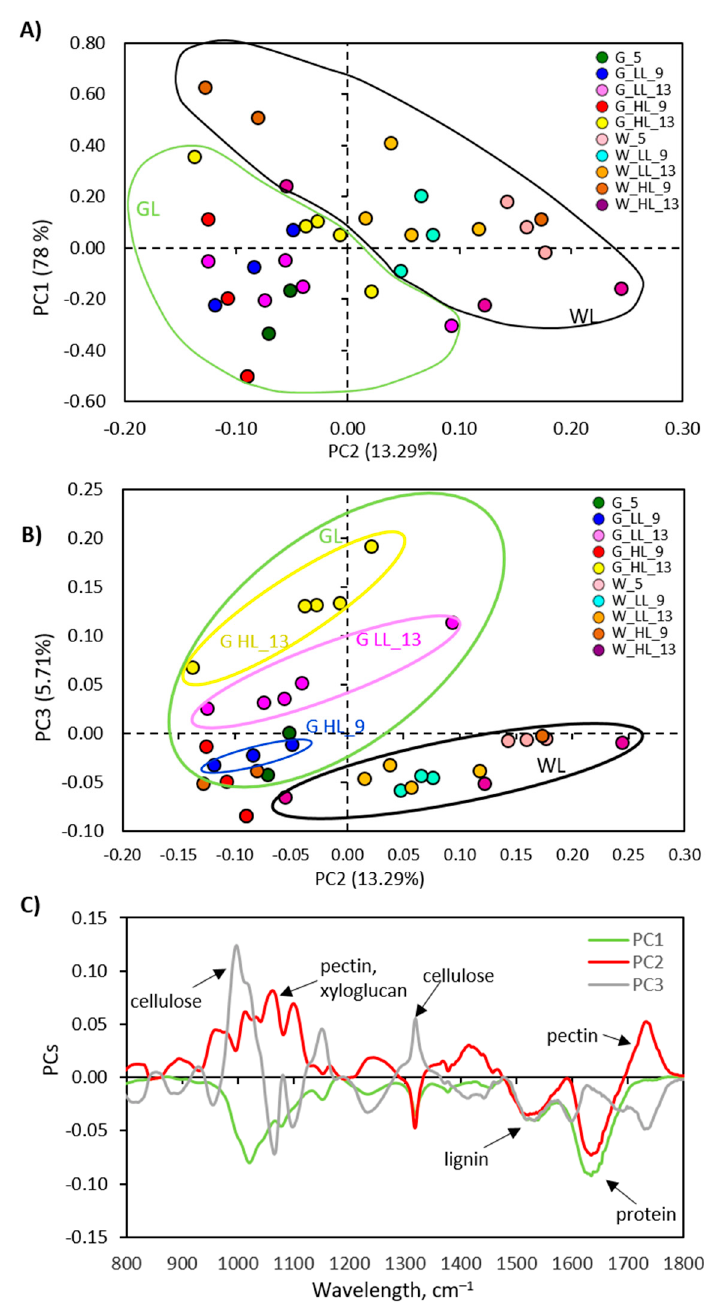
Figure 10. Graphical representation of the ( A , B ) scores and ( C ) loadings PC1, PC2, and PC3 deter- mined using the spectral range 800–1800 cm − 1 of GL and WL samples.